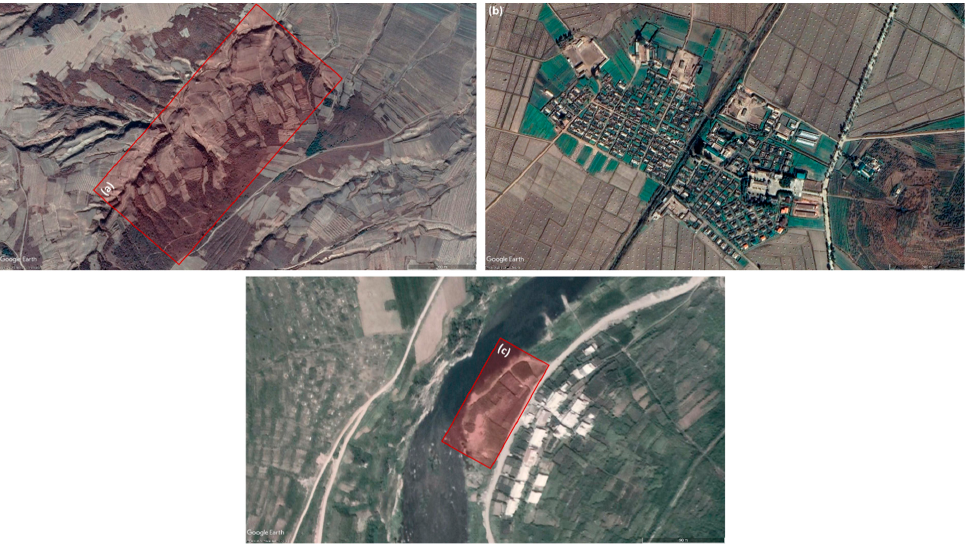
Figure 8. Spatial characteristics of the ‘sotoji’. ( a ): between Onsong and Sambong, North Hamgyong; ( b ) the Sambong cooperative farm, Phyeongwon; ( c ) Hyesan, Ryanggang (Image sources: Google Earth, date of access: 17 October 2019).